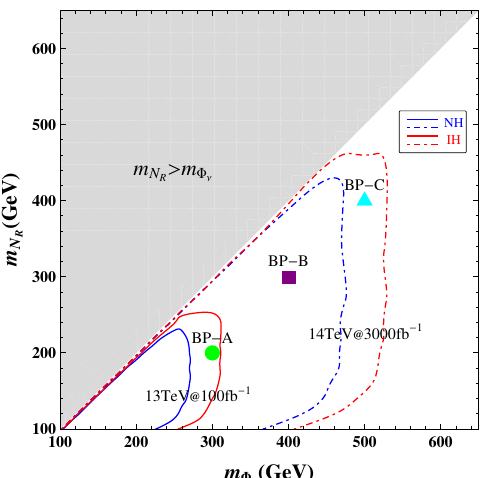
Figure 17 . Same as (cid:12)gure 12, but for the four-lepton